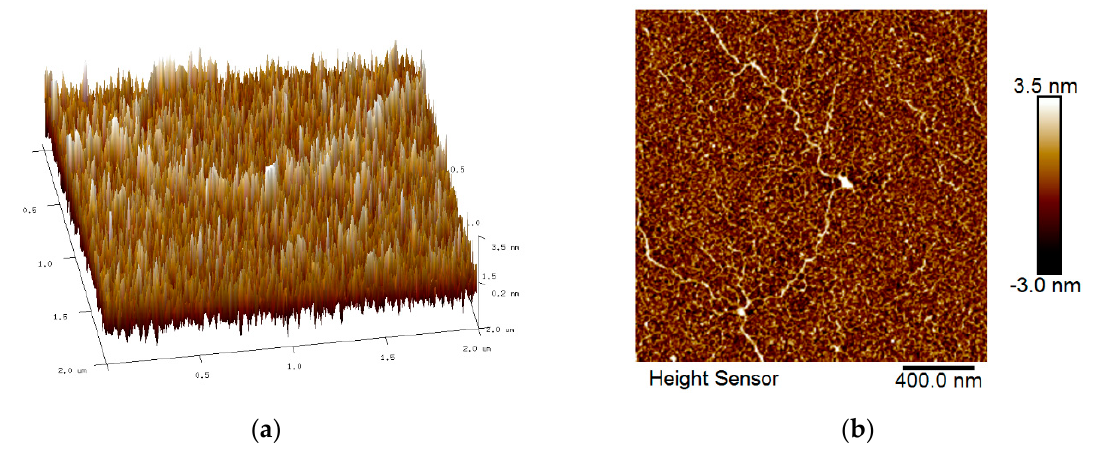
Figure 5. AFM images of GQDs thin film: ( a ) 3D image and ( b ) 2D image.